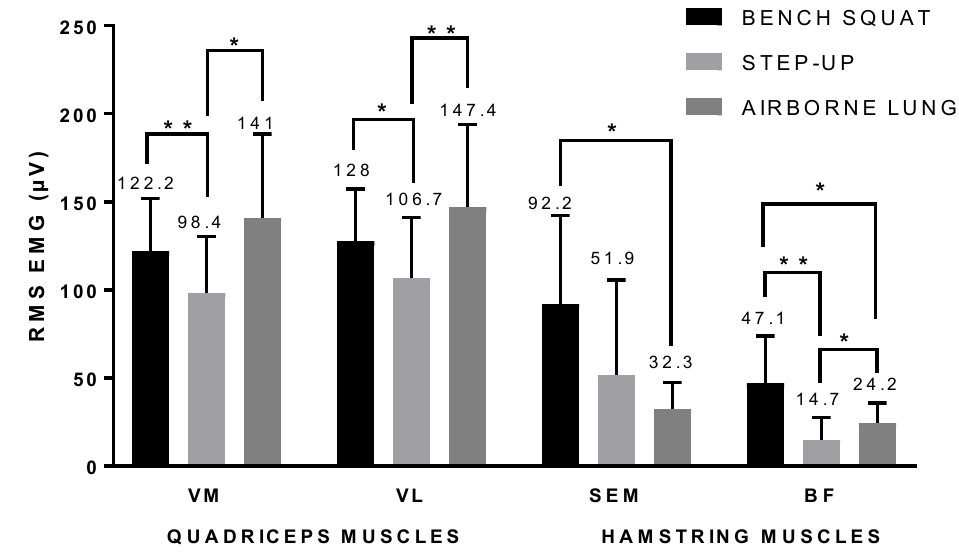
Figure 3. Multiple comparison of the RMS values in descending phase (*:p<0.05; **:p<0.01): (VM: Vastus medialis; VL: Vastus lateralis; SEM: Semitendinosus; BF: Biceps femoris)